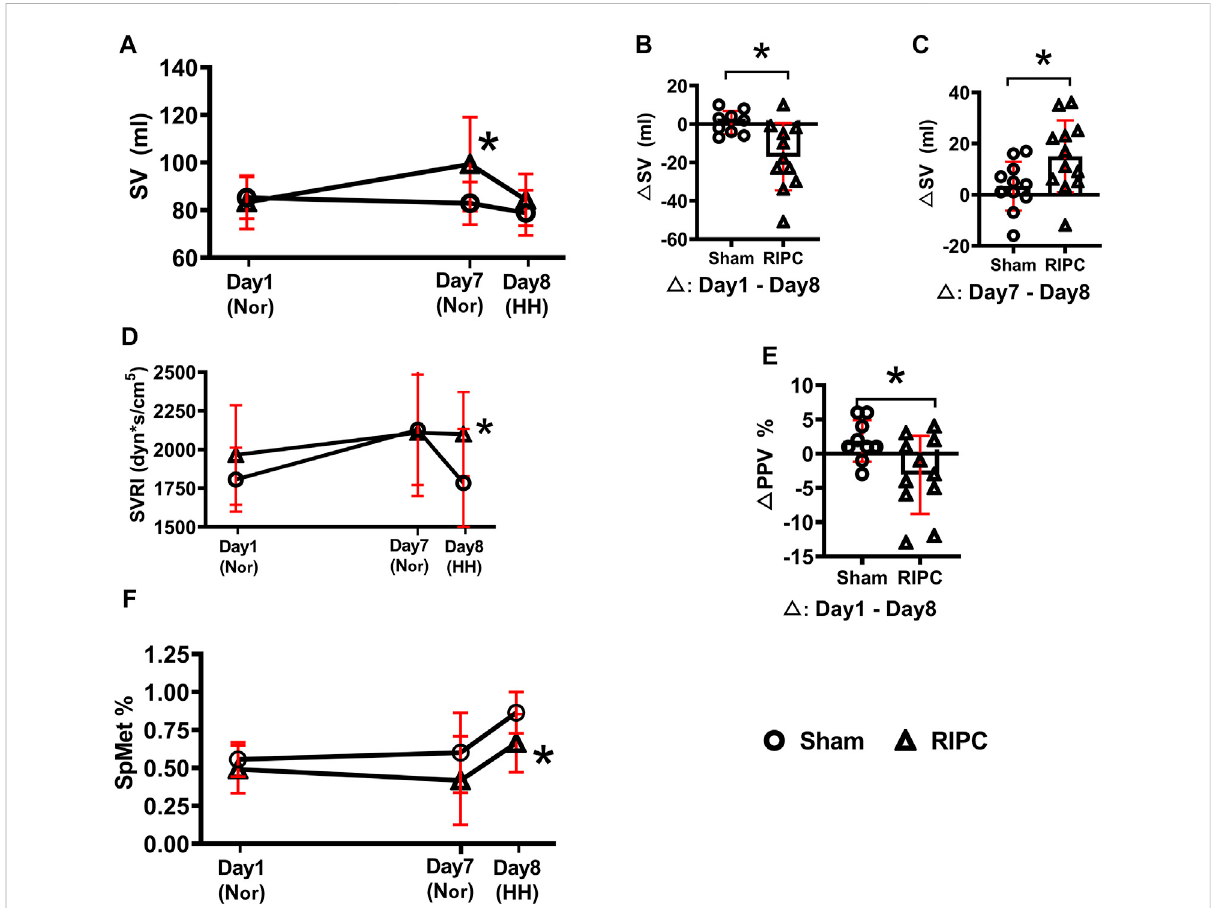
FIGURE 5 ThechangesofphysiologicalvariablesinducedbyRIPC. (A) SV, (B,C) △ SV, (D) SVRI ,(E) △ PPV,and (F) SpMetandfromnormoxictoHHcondition in each group. * p < 0 .05 vs. sham group. Values are presented as mean ± standard deviation. Nor: normoxic, HH: hypobaric hypoxia, RIPC: remote ischemic preconditioning, SV: stroke volume, SVRI: systemic vascular resistance index, PPV: pulse pressure variation, SpMet: methemoglobin